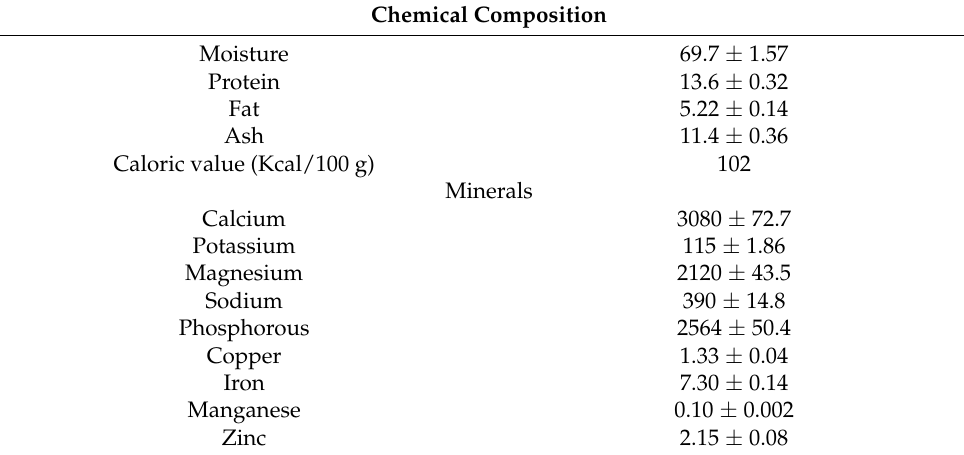
Table 3. Chemical (g/100 g) and mineral composition (mg/100 g) of meat-bone